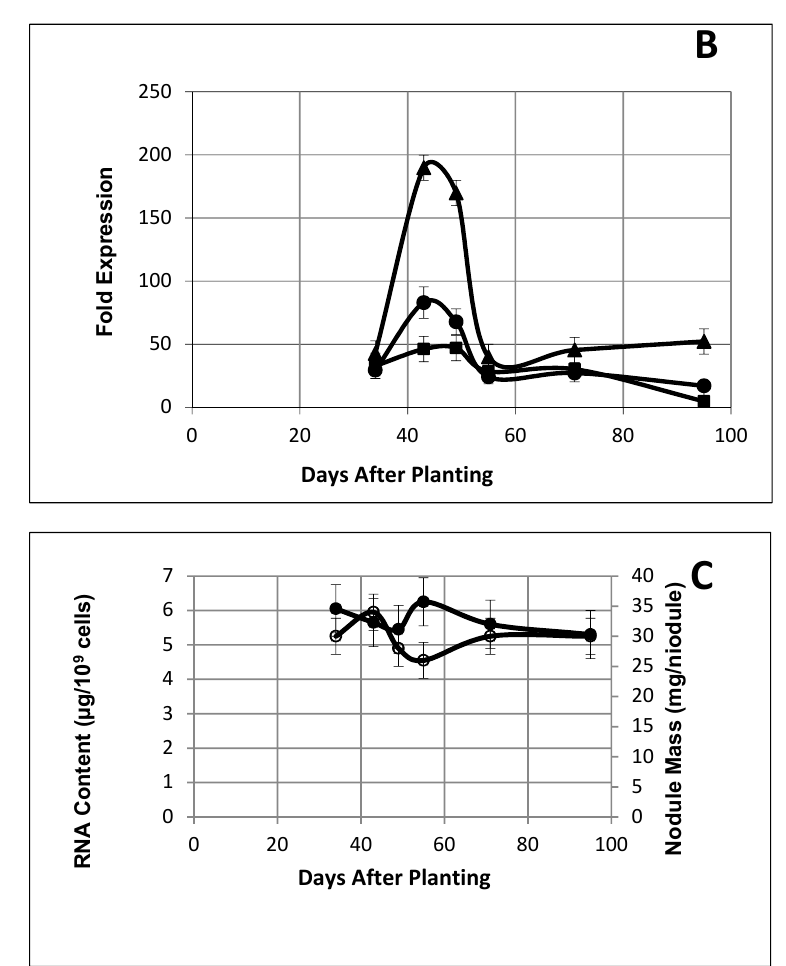
Figure 1. ( A ) Acetylene reduction activity of soybean nodules as a function of days after planting. Values are the means of three replicates. ( B ) Nitrogenase component gene expression from microarray data as a function of days after planting. Symbols represent the molybdenum–iron protein, alpha subunit ( ● ); molybdenum–iron protein, beta subunit ( ■ ); iron protein ( ▲ ). Each value is the average of three samples ± S.D. ( C ) Total RNA isolated from soybean nodule bacteroids and soybean nodule mass as a function of days after planting. Values are means of at least three replicates. Solid symbols are RNA content; open symbols are nodule mass. Int. J. Mol. Sci. 2018 , 19 , x FOR PEER REVIEW